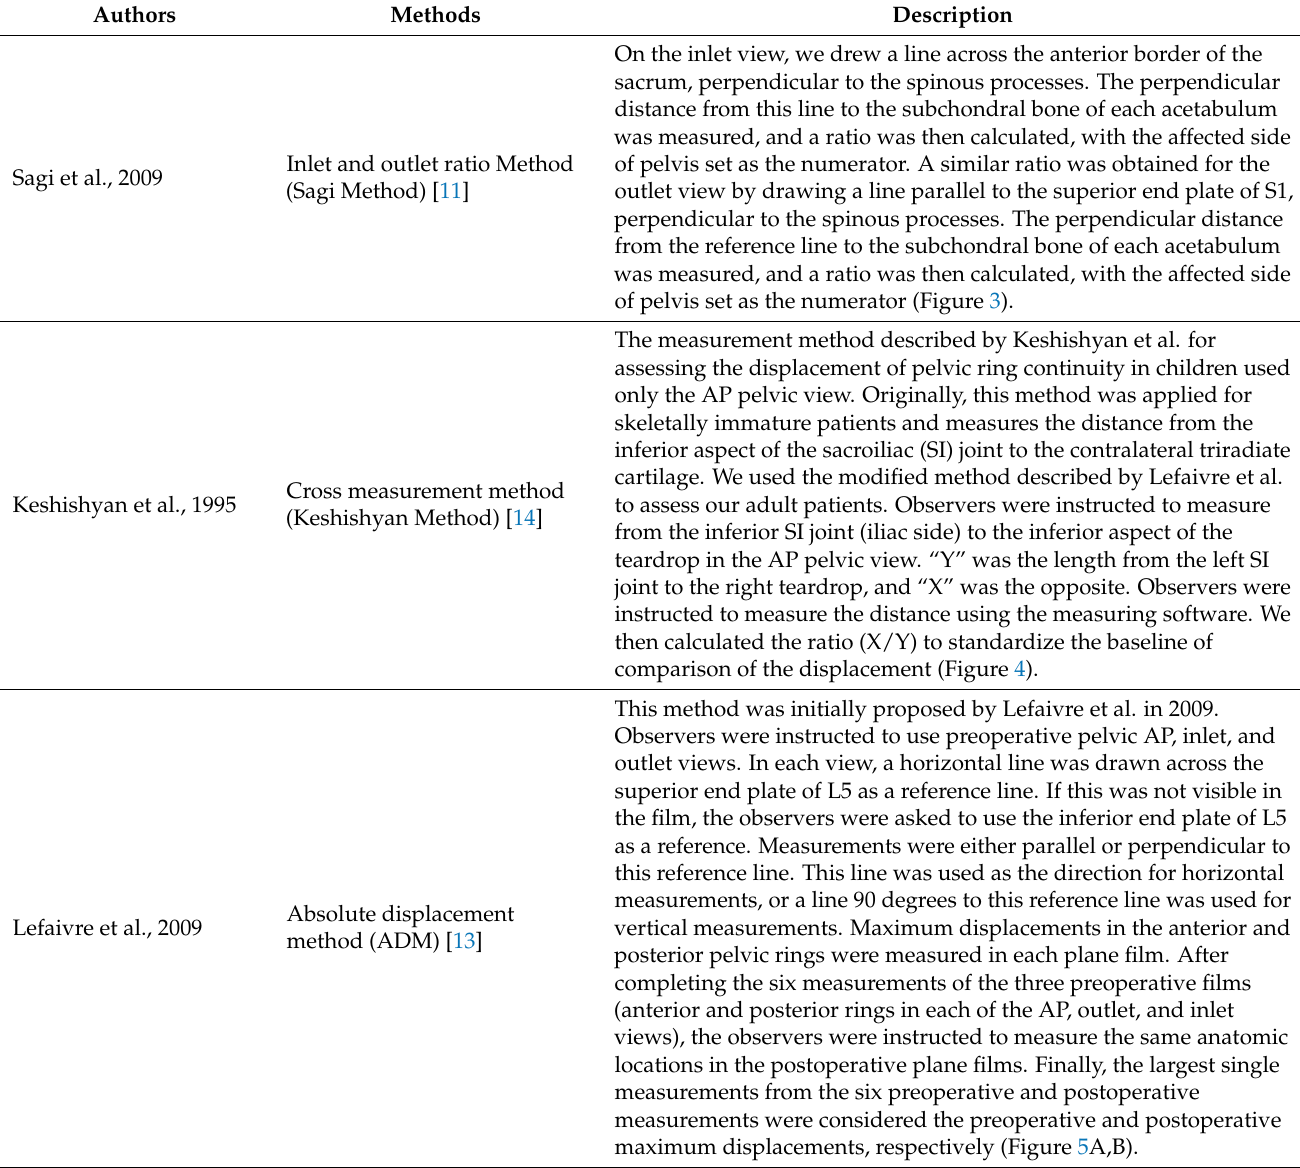
Table 1. Radiographic measurement methods for assessment of displacement and symmetry for pelvic fracture with spinopelvic